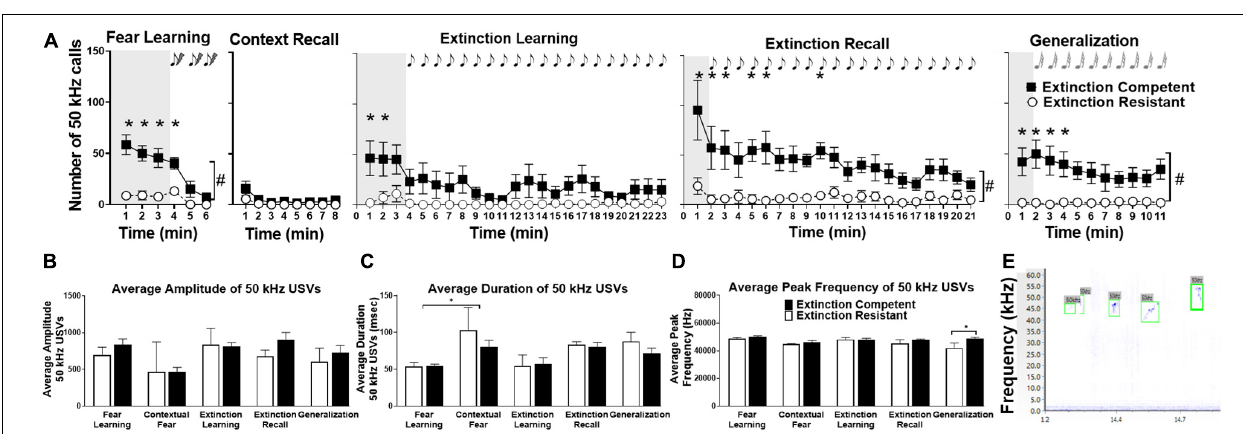
FIGURE 4 | Female rats emitted significant numbers of 50 kHz ultrasonic vocalizations (USVs) during fear learning, extinction learning, extinction recall, and generalization trials, although fewer 50 kHz USVs were seen during contextual fear recall. Panel (A) shows extinction competent (filled squares, EC) females emitted a significantly greater number of 50 kHz USVs compared to extinction resistant (open circles, ER) rats over time. The shaded areas represent the unconditioned vocalizations before tone–shock pairings (fear learning) or the first conditioned/novel tone (extinction learning, extinction recall, and generalization). During acquisition, EC rats emit significantly more 50 kHz USVs than the ER rats predominantly during the first 3 min of exposure to Context A prior to tone–shock pairings; 50 kHz USVs decreased during fear acquisition and the tone–shock pairings. Similar to acquisition, EC rats emit more 50 kHz USVs than ER rats during extinction learning, extinction recall, and generalization trials, and the number of 50 kHz USVs was greatest during periods before the tone presentations and decreased over time in these trials. Panels (B–D) show that acoustic parameters of 50 kHz USVs were similar in EC and ER phenotypes including the average amplitude of each call (B) , average duration of each call (C) , or average peak frequency of the calls (D) across all trials, with the exception of an ER–EC difference in frequency during generalization. Panel (E) shows a representative spectrogram of 50 kHz USVs; the green boxes identify the detected USVs using UltraVox software. Points and bars represent mean ± SEM, with N = 7 ER and N = 7 EC rats per group. # P < 0.05 main effect of phenotype; * P < 0.05 significant phenotypic differences at 1-min